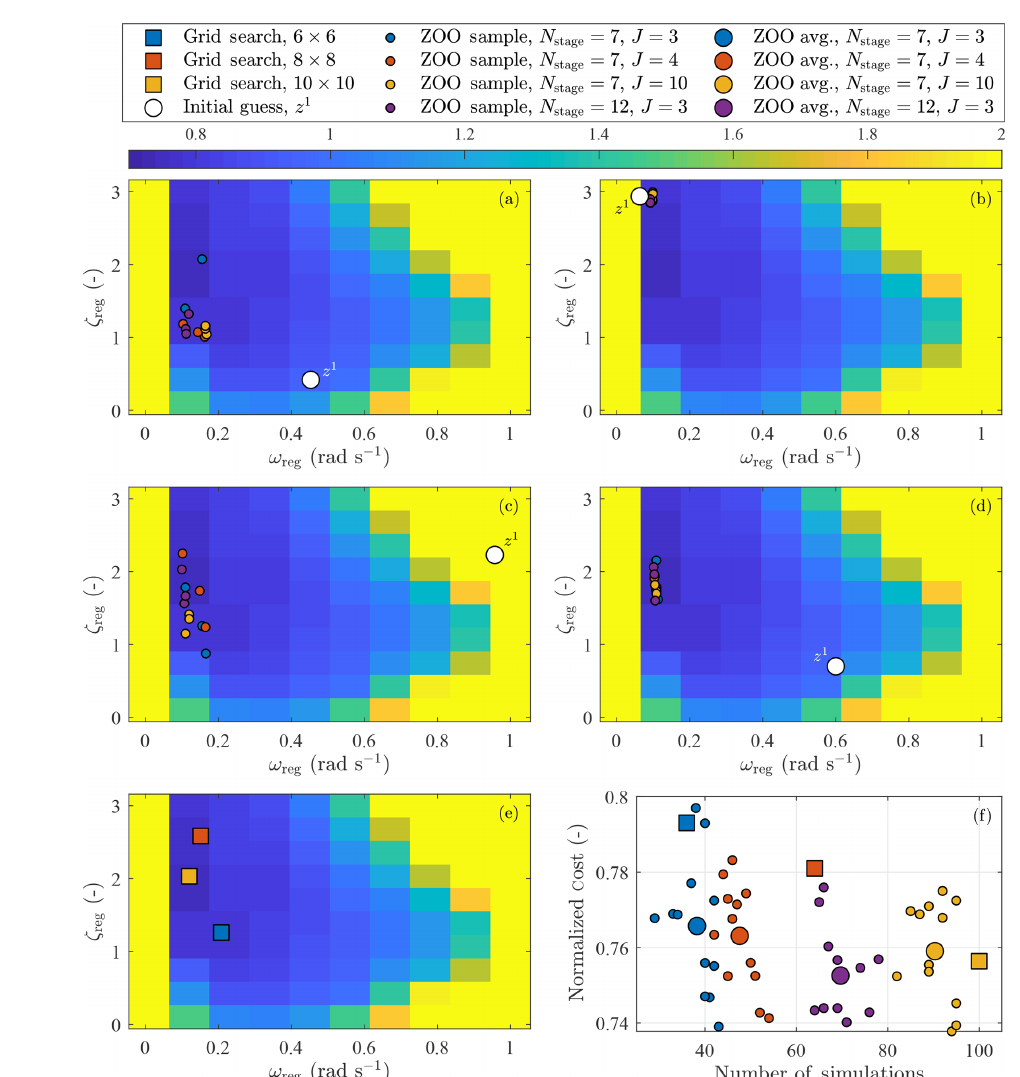
Figure 6. Panels (a) – (d) show the result of performing the zeroth-order optimization (ZOO) for the baseline rotor speed controller using N stage = 7 and 12 stages and J = 3 , 4 , and 10 samples per stage, using four different initial conditions ( z 1 ). The background image of panels (a) – (e) is of the cost function, sampled using a grid search with a 10 × 10 level of precision using the hard bounds in Table 2 and normalized to the cost when z 1 = z sug . Panel (e) shows the optimal solutions of three different grid search resolutions. Panel (f) compares the optimal costs, normalized to the initial cost when z 1 = z sug , compared with the number of simulations used to find the